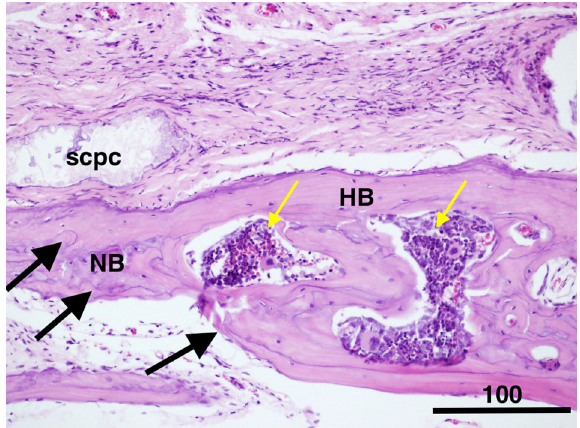
Fig. 5 Photomicrographs showing decalci fi ed histological sections of Group 1 (DSM/SCPC/hBMSC) stained with H&E. The integration between the newly formed bone and the host bone. The presence of the reversal lines in the newly formed bone denoted with a black arrow; large marrow spaces are denoted with a yellow arrow, scale bar = 100 μ